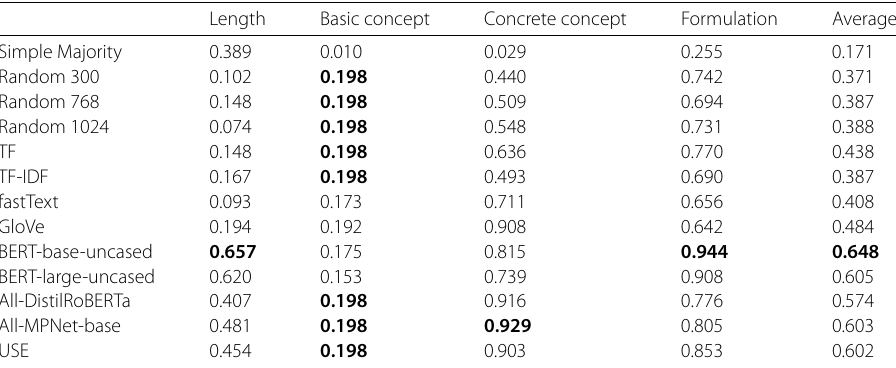
Table 3 Results of Content Validity Analysis: Prediction Accuracy Scores of Probing Classifiers. Note that sentence length is converted into a categorical variable with four levels including “0-10”, “11-12”, “13-15” and “16-25”; basic concept, concrete concept and formulation are also categorical with 13, 117 and 5 levels, respectively Length Basic concept Concrete concept Formulation Average Simple Majority 0.389 0.010 0.029 0.255 0.171 Random 300 0.102 0.198 0.440 0.742 0.371 Random